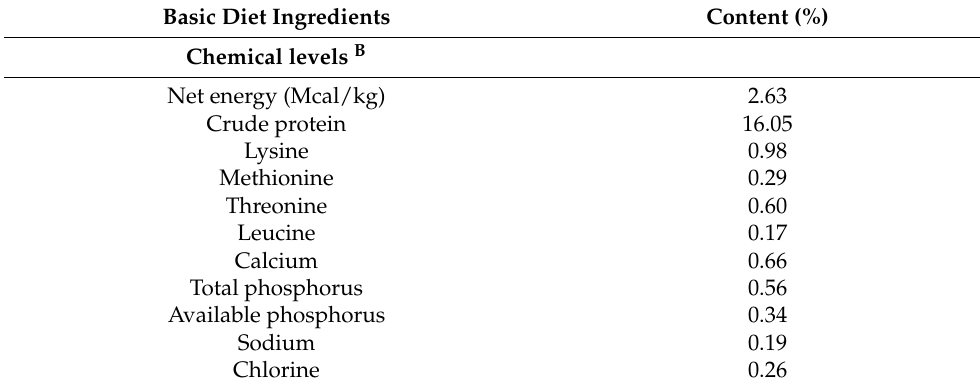
Table 2. Cont. Basic Diet Ingredients Content (%) Chemical levels B